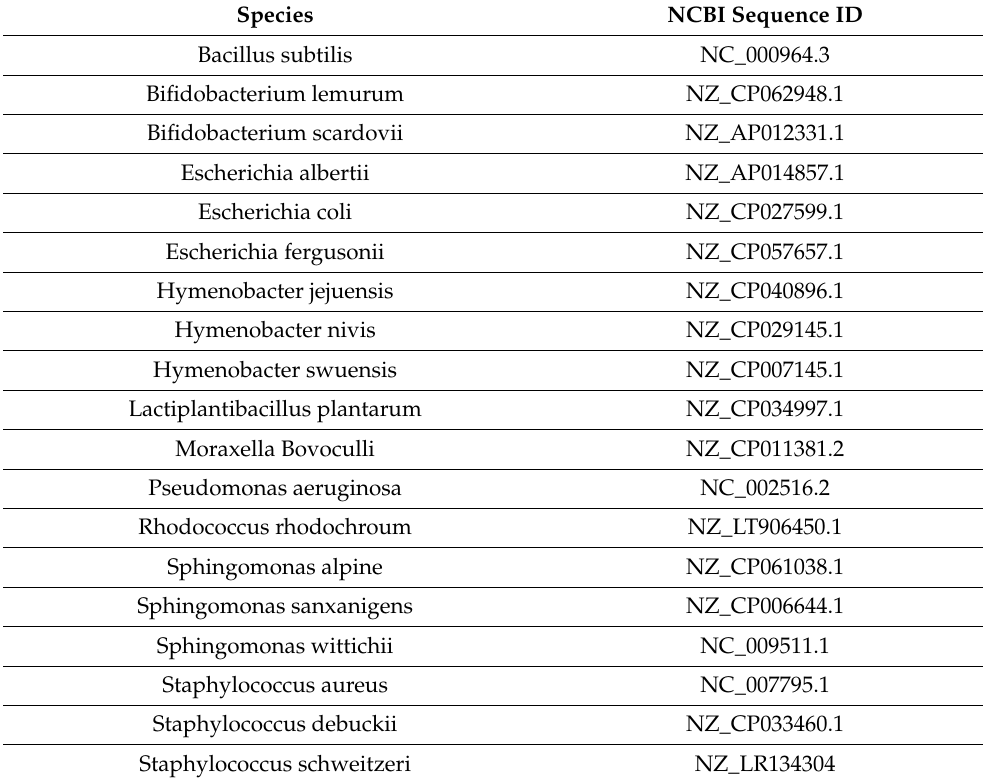
Table A1. Bacterial genomes and their IDs for NCBI, used to construct artificial mix of bacterial transcriptomes to test how accurate are methods we used for taxonomic identification of reads originated from microbial